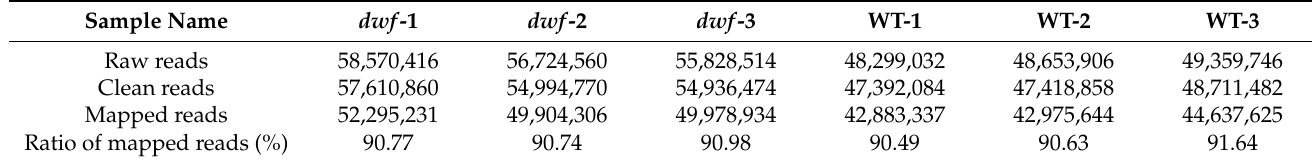
Table 1. Summary of read numbers in WT and dwf.